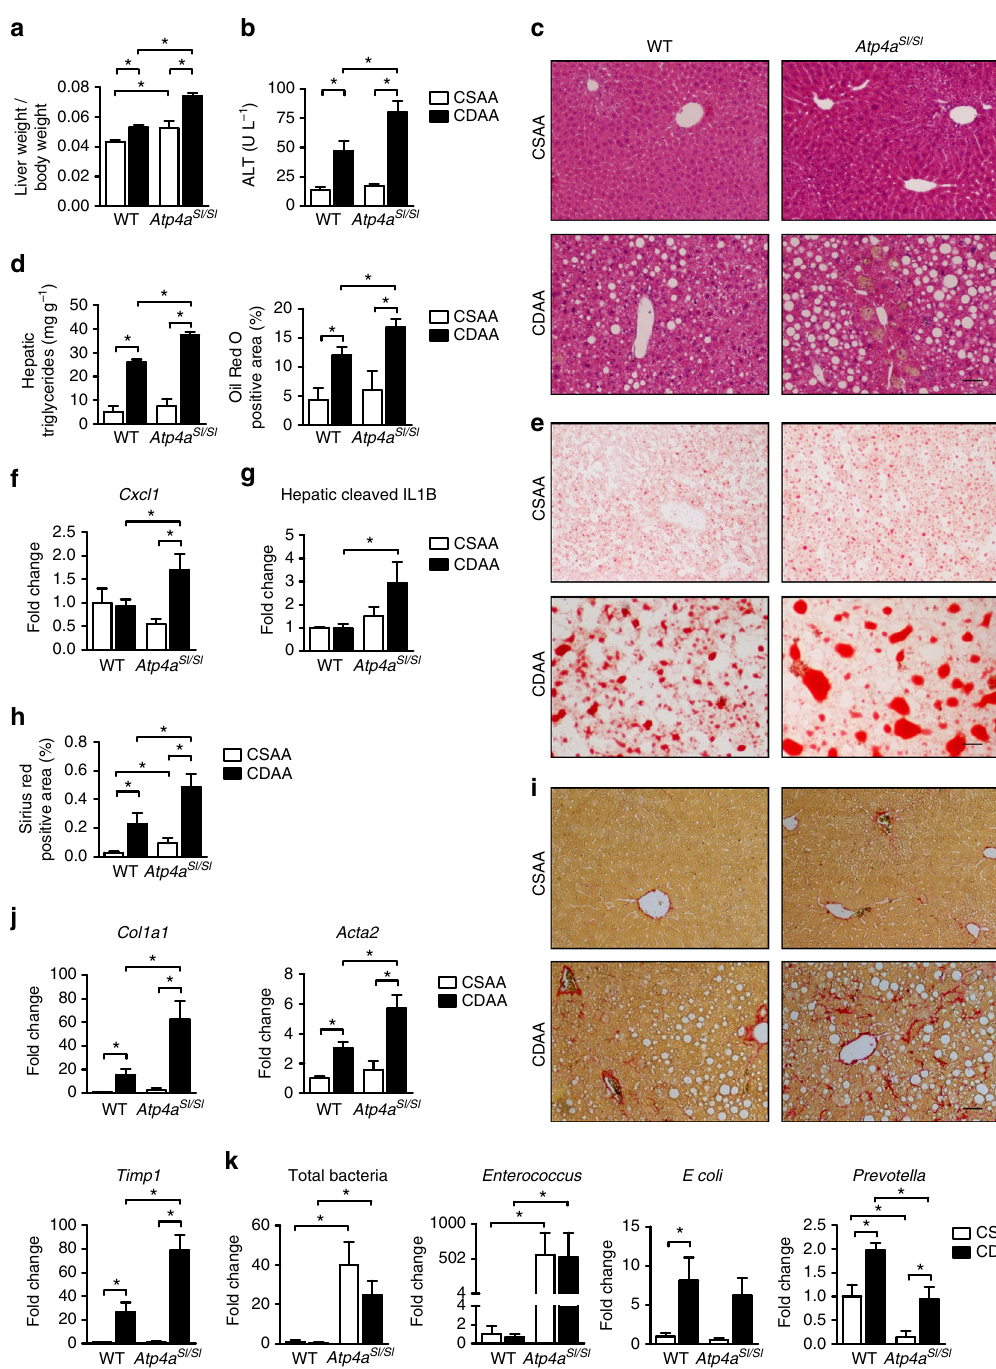
Fig. 3 Exacerbated NASH in Atp4a Sl/Sl mice. WT mice and their Atp4a Sl/Sl littermates were fed a CSAA (control, n = 4 – 9; 1 – 3 replicates) or CDAA diet ( n = 10 – 12; 4 – 5 replicates) for 20 weeks. a Ratio of liver to body weight was signi fi cantly higher in CDAA-fed Atp4a Sl/Sl mice than CDAA-fed WT mice, b as was mean plasma level of ALT. c Representative liver sections, stained with hematoxylin and eosin. d Hepatic triglyceride content. The Oil Red O-stained area was quanti fi ed by image analysis ( n = 5 – 12). e Representative Oil Red O-stained liver sections. f Hepatic expression of mRNA encoding the chemokine Cxcl1 . g Hepatic levels of cleaved IL1B ( n = 2 – 5). h Collagen deposition was evaluated by Sirius red staining and quanti fi ed by image analysis ( n = 5 – 13). i Representative sections stained with Sirius red. j Hepatic expression of genes involved in liver fi brosis including Col1a1 , Acta2 (smooth muscle α -actin, a marker of activated myo fi broblasts), and Timp1 (tissue inhibitor of metalloproteinase 1). k Total bacteria, proportions of Enterococcus , E. coli , and Prevotella in fecal samples, measured by qPCR. Proportions of fecal E. coli did not differ signi fi cantly between WT and Atp4a Sl/Sl mice. Numbers of Prevotella were lower in Atp4a Sl/Sl mice than in WT mice, with or without CDAA feeding. Numbers of Enterococcus were signi fi cantly higher in Atp4a Sl/Sl mice than in WT mice, with or without CDAA feeding. Scale bars = 100 μ m. Results are expressed as mean ± s.e.m. For a , b , d , f , g , h , j , k signi fi cance was evaluated using the unpaired Student t -test or Mann – Whitney U -statistic test.* P <